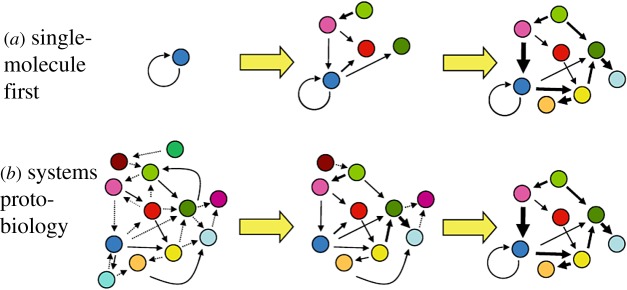
Two alternative views of the progression from early molecular entities to more life-like networks. (a) Early evolutionary steps involve one molecule type with template self-replication capacity, recruiting other components and progressing gradually towards the evolutionary target by increasing network size. (b) Early networks with a large number of nodes and low interaction fidelity progress gradually by node weeding and modification, undergoing fidelity enhancement, towards the same evolutionary target. Reproduced from [85].